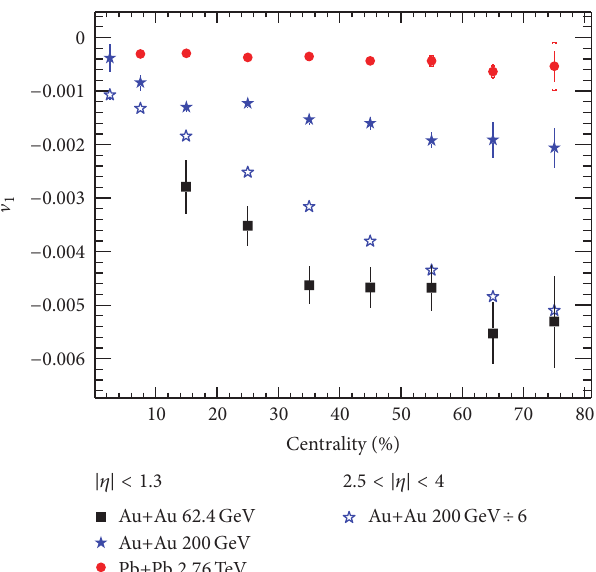
Figure 4: V 1 of charged particles as a function of centrality for a midpseudorapidity region ( |𝜂| < 1.3 ) and a forward pseudorapidity region ( 2.5 < |𝜂| < 4.0 ). Two RHIC datasets, 62.4 and 200 GeV Au+Au [44], and one LHC dataset, 2.76 TeV Pb+Pb [53], are shown at midpseudorapidity, while only 200GeV Au+Au [44] is shown at forward pseudorapidity. Note that the data points at forward pseudorapidity are divided by 6 in order to be plotted on a common scale with the data at